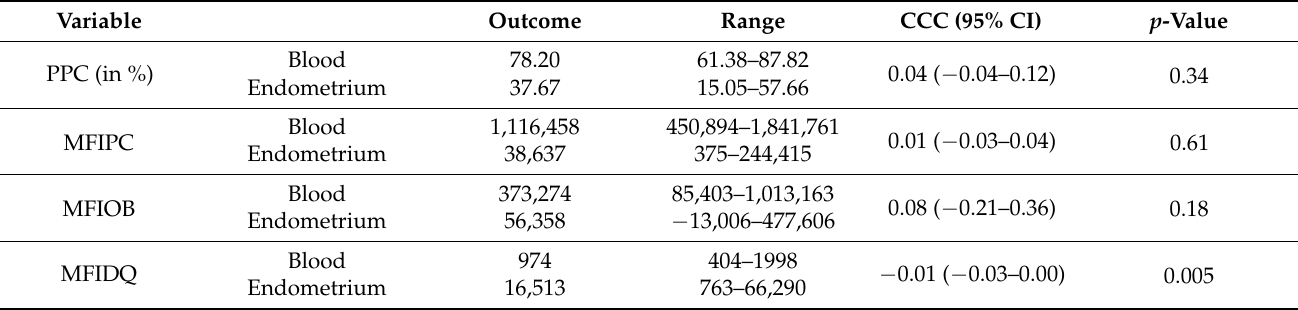
Table 4. Flow cytometric evaluation of polymorphonuclear leukocyte (PMN) functionality in blood versus endometrium via oxidative burst (OB), phagocytosis (PC), and intracellular proteolytic degradation by DQ ovalbumin (DQ-ova). Blood and endometrial samples ( n = 11) were collected from Holstein-Friesian cows at 9–37 days in milk. The functionality outcomes of endometrial PMN were related to blood PMN. Functionality measures included percentage of PMN that performs PC (PPC), median fluorescence intensity (MFI) of PMN that displayed OB (MFIOB), PC (MFIPC), or DQ-ova (MFIDQ) relative to the MFI of the respective autofluorescence control. Samples were not immunolabeled, and gating was performed based on morphometrical characteristics (high FSC and high SSC). Lin’s concordance correlation coefficient (CCC) and 95% confidence interval (CI) are reported with the p -value from the corresponding Pearson (parametric) or Spearman (non-parametric) test. Correlations were considered significant at p <